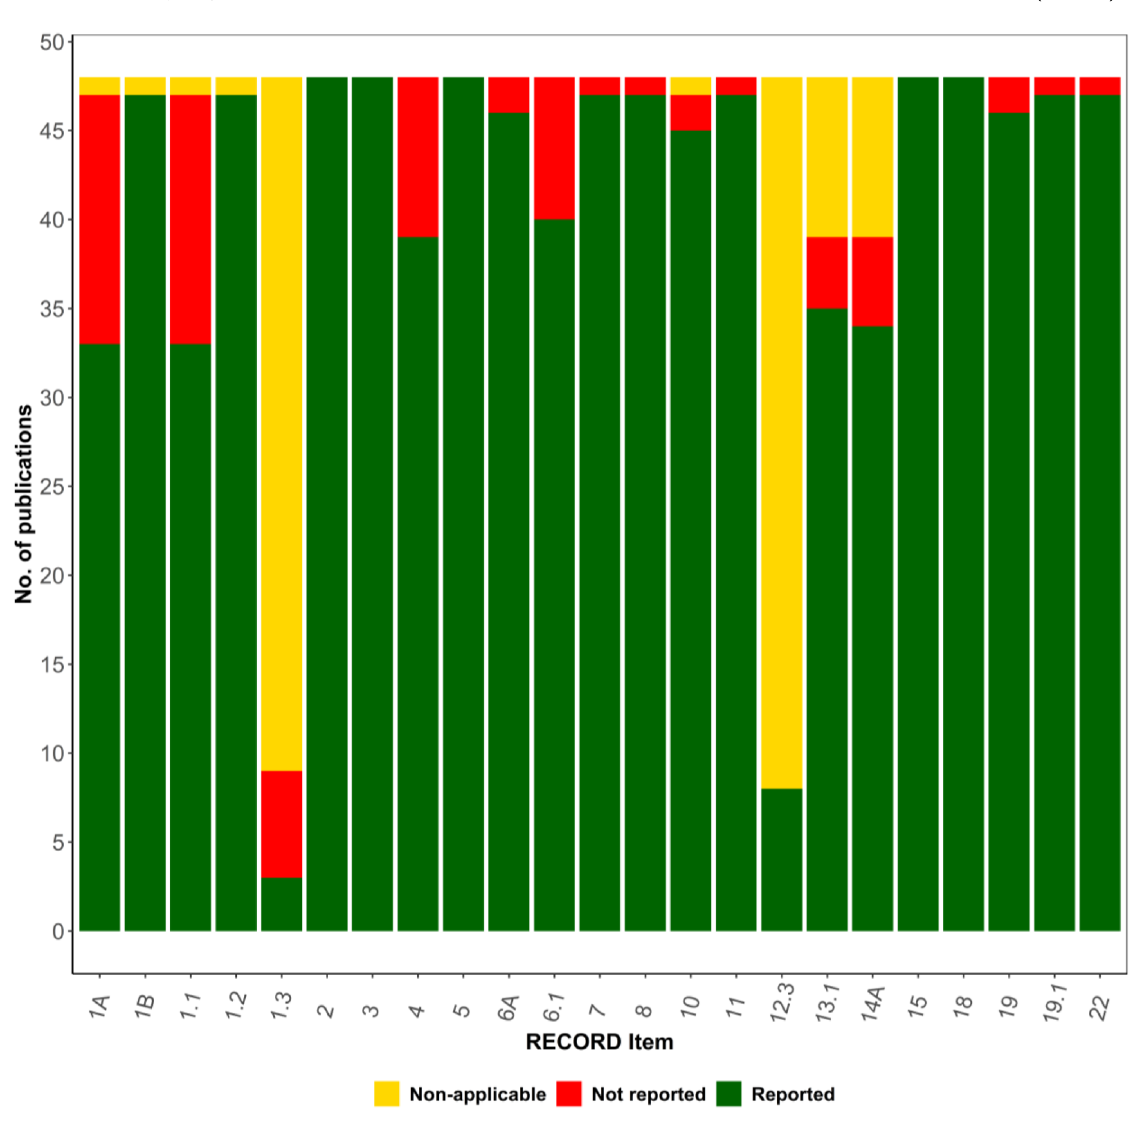
Supplementary Figure 2: RECORD classification of studies published in 2018 per evaluated item (n =